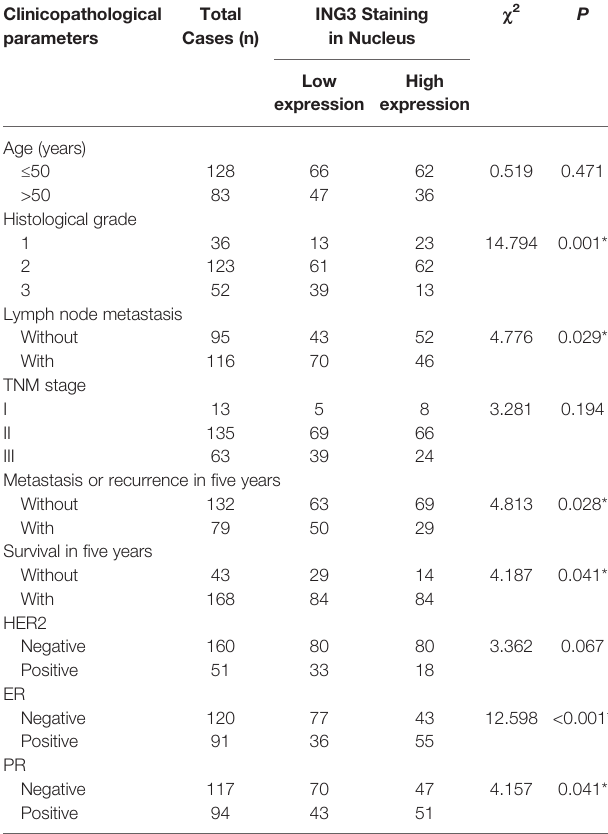
TABLE 1 | The nuclear ING3 expression and clinicopathological parameters in breast